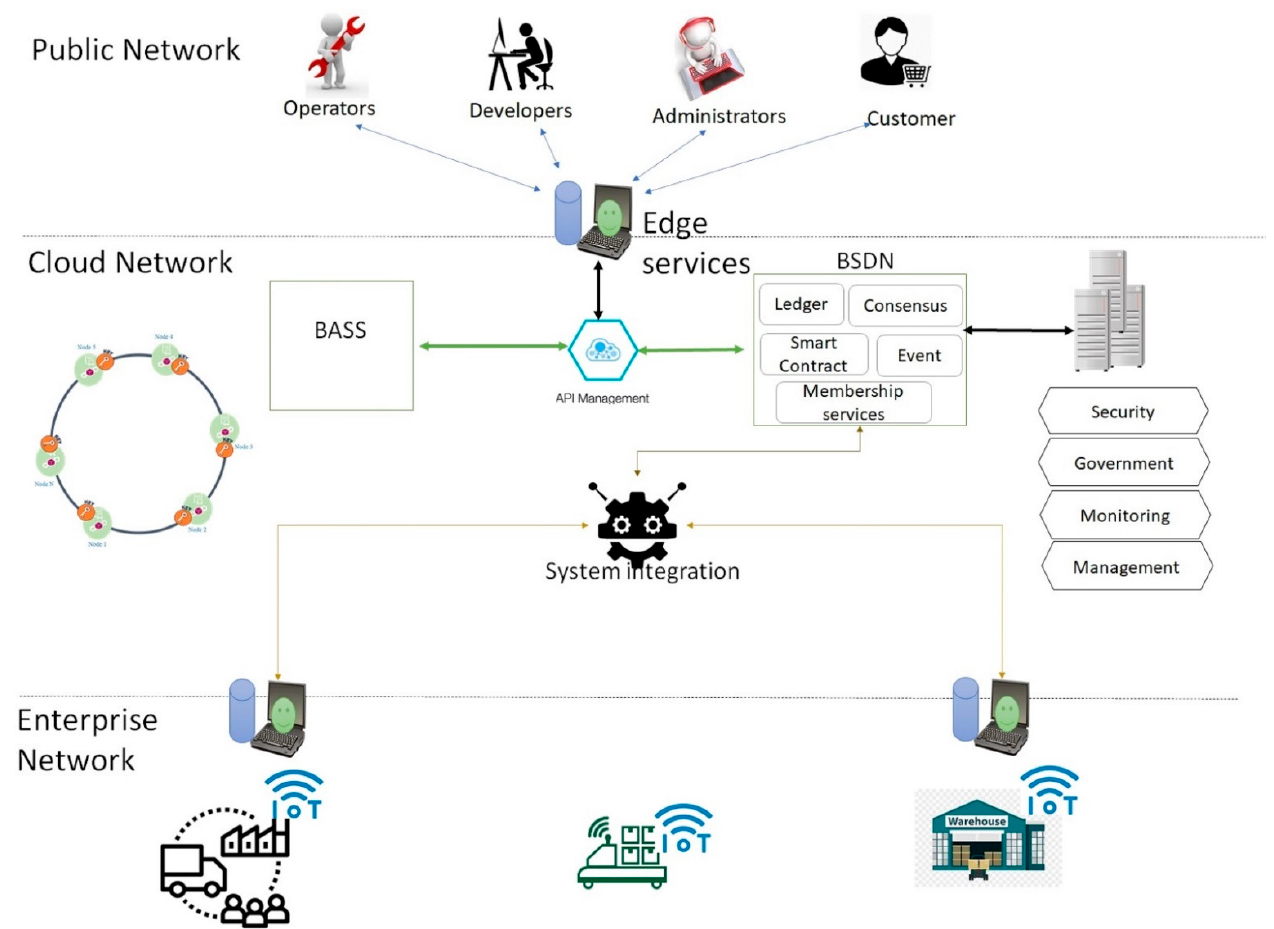
Figure 5. Typical capabilities needed for customers or service providers .